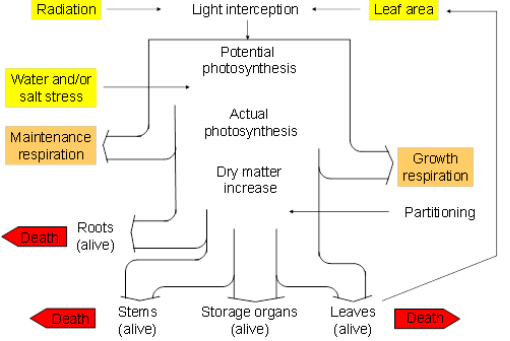
Figure 4. Flow chart of crop growth processes included in